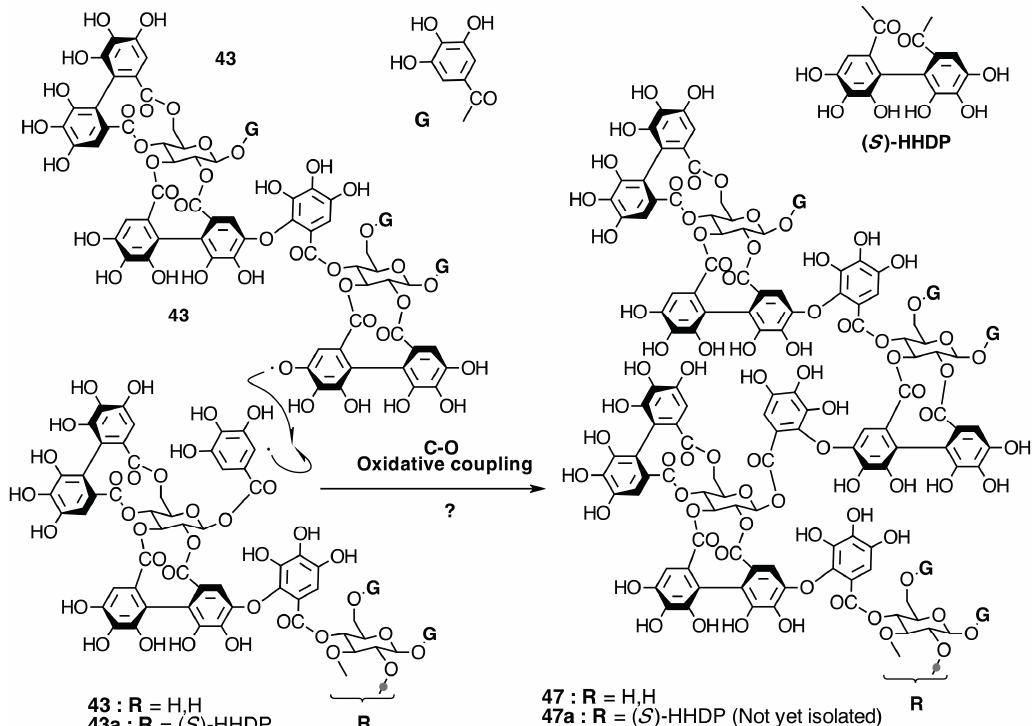
Figure 21. Route S in the biogenesis of tetrameric ellagitannins in Melastomataceae. ? = Enzymes and reaction conditions are not yet clarified.